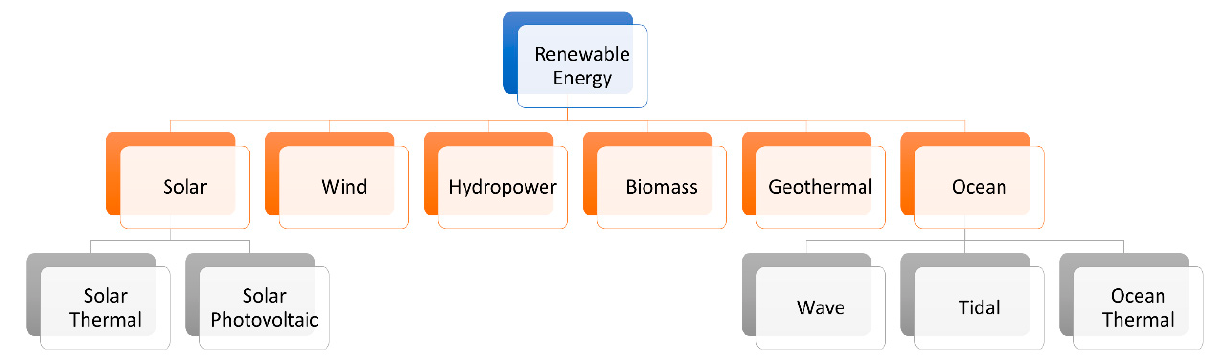
Figure 5. Classification of main renewable energy resources.